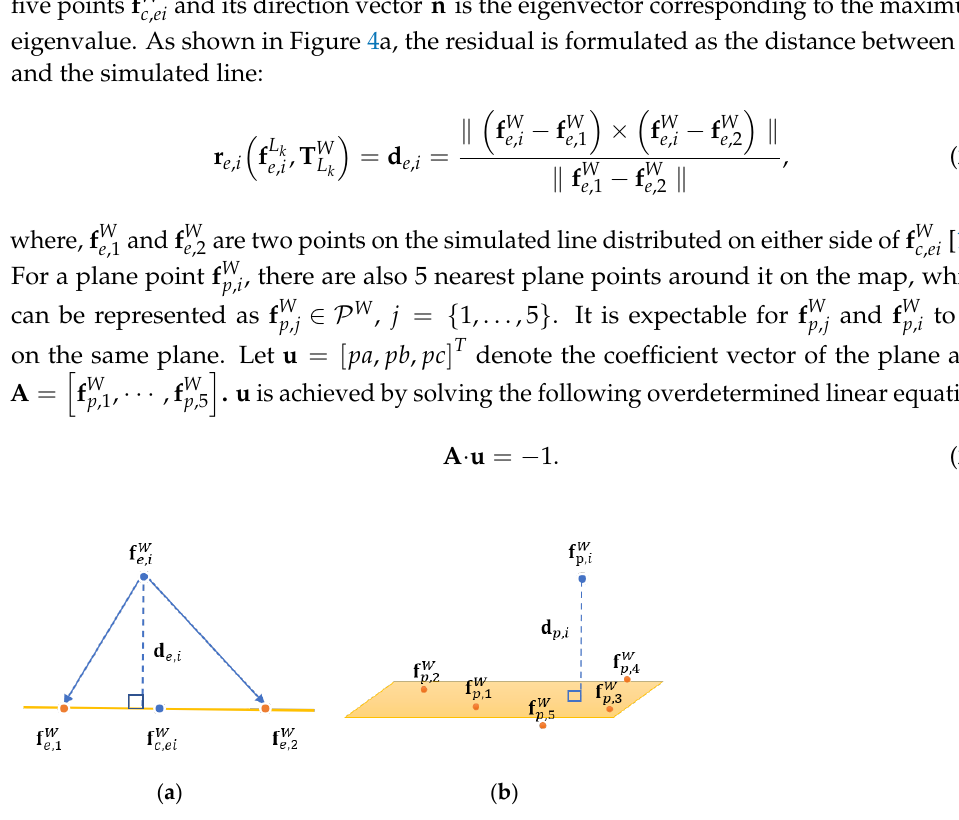
Figure 4. Illustration of point-to-line residual for edge feature point and point-to-plane residual for plane feature point used in LiDAR scan-to-map registration: ( a ) Point-to-line residual for an edge feature point 𝐟 𝑒,𝑖 𝑊 of the current LiDAR frame, the orange line is the fitted line passing 𝐟 𝑐,𝑒𝑖 𝑊 ; ( b ) Point-to-plane residual for a plane point 𝐟 𝑝,𝑖𝑊 of the current LiDAR frame, the orange plane is the fitted plane using 𝐟 𝑝,𝑗𝑊 ∈ 𝒫 𝑊 ,𝑗 = {1, ⋯ ,5} .